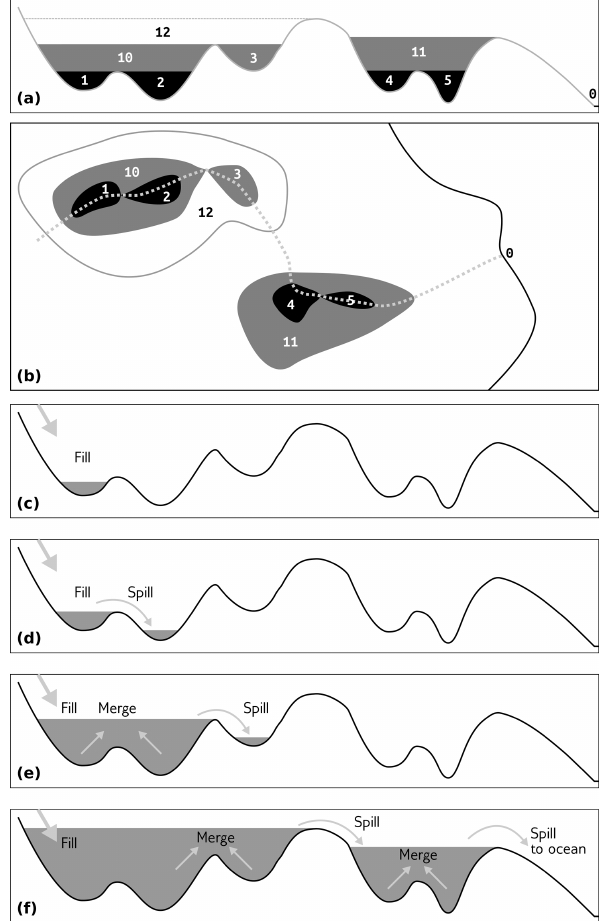
Figure 3. The Fill–Spill–Merge process. Water moves through to- pographic depressions by filling them, spilling over sills, and merg- ing to form meta-depressions. (a) Topographic cross section with labeled leaf depressions and their parents, following the left-hand side of the depression hierarchy in Fig. 2. The number 0 repre- sents the ocean; other numbers represent leaves and parents that together form depressions and meta-depressions. (b) Map showing this depression structure; the cross section in (a) follows the dot- ted gray line. (c) A water source to the left begins to fill depression 1. (d) Continued water input causes depression 1 to overflow and spill into depression 2. (e) Depression 2 fills, causing depressions 1 and 2 to fill their parent (10) and merge to form a meta-depression. This meta-depression overflows into depression 3. (f) Depression 3 fills and merges with meta-depression 10 (1 and 2 being implied members based on their position in the hierarchy) to flood their par- ent, 12. After meta-depression 12 overspills, it enters depression 4, which then fills and spills into depression 5. After depression 5 floods, its waters join with those from depression 4 to fill meta- depression 11, which then spills to the ocean. Figures 4 and 5 de- scribe the algorithm in more specific